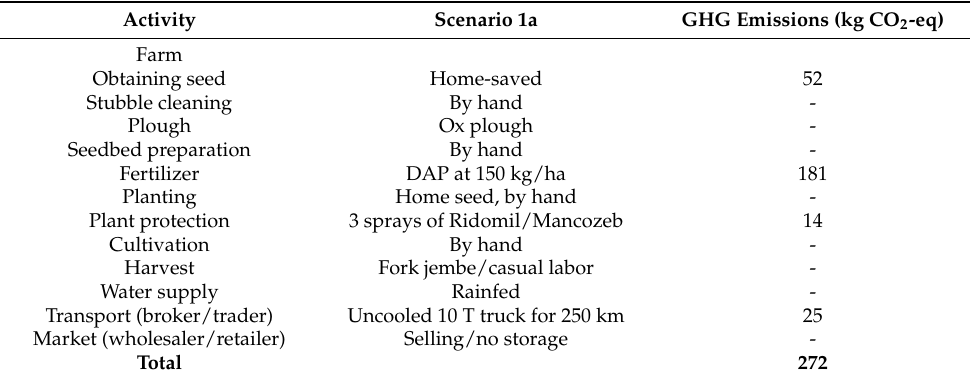
Table 8. Detailed Overview of GHG Emissions per ton of Marketable Product in Scenario 1a.